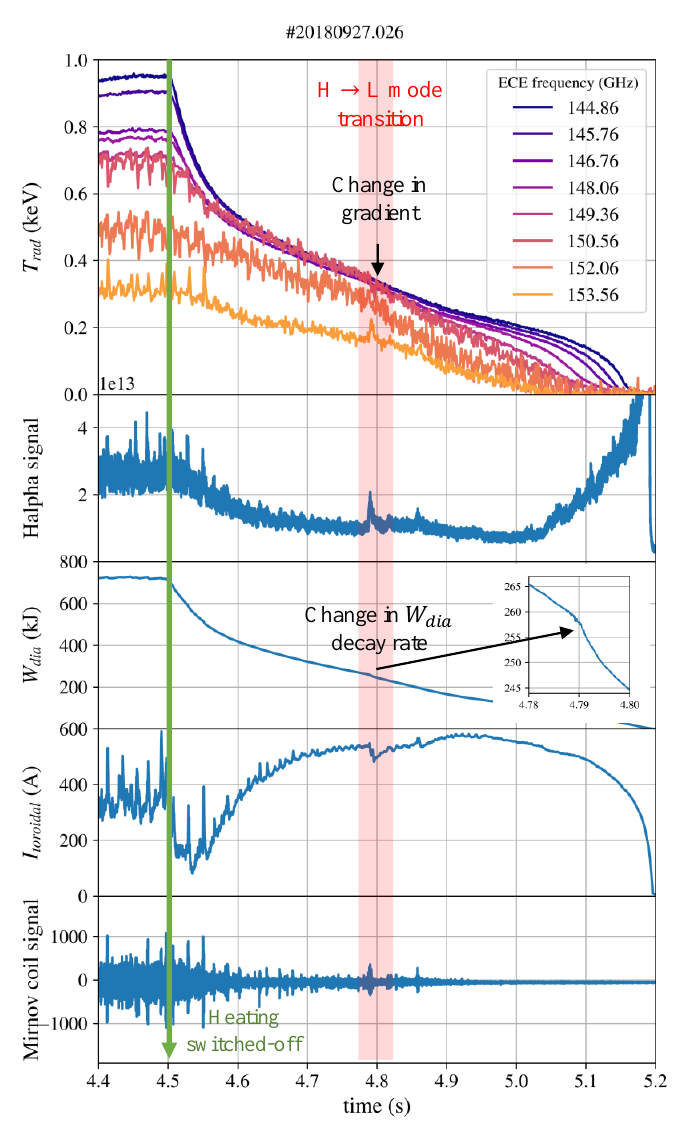
Figure 5: Time traces of ECE, H-alpha, W dia , I tor , and magnetic fluctuations are shown for the plasma discharge #20180927.026 where the magnetic island chain was moved inside the edge confinement region. Plasma heating was switched-o ff at 4.5 s, and at approximately 4.8 s, transition to a degraded confinement state can be observed through increased W dia decay rate and changed temperature gradient with occurrence of an ELM-like crash (top